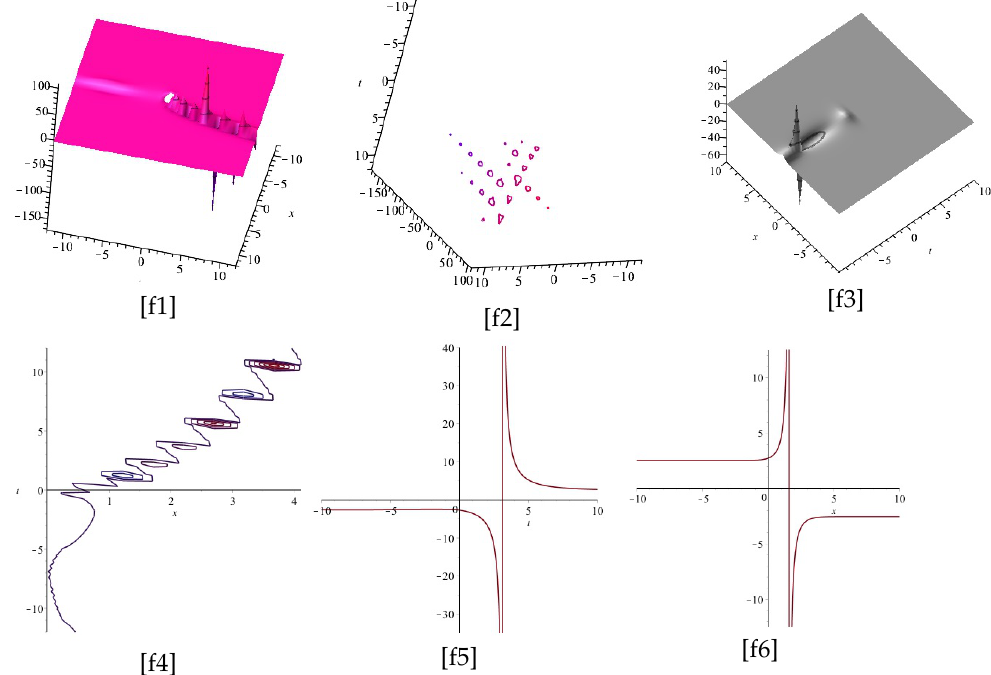
Figure 6. The plots of Equation (30), for λη < 0 and α = 0.5. Now, [f1] and [f3] are imaginary and real parts of Equation (30), and [f2], [f4], [f5], and [f6] display the z -axis orientation, the contour plot, the 2d for x = 2, and the 2d for t = 2, of the imaginary part of [f1],